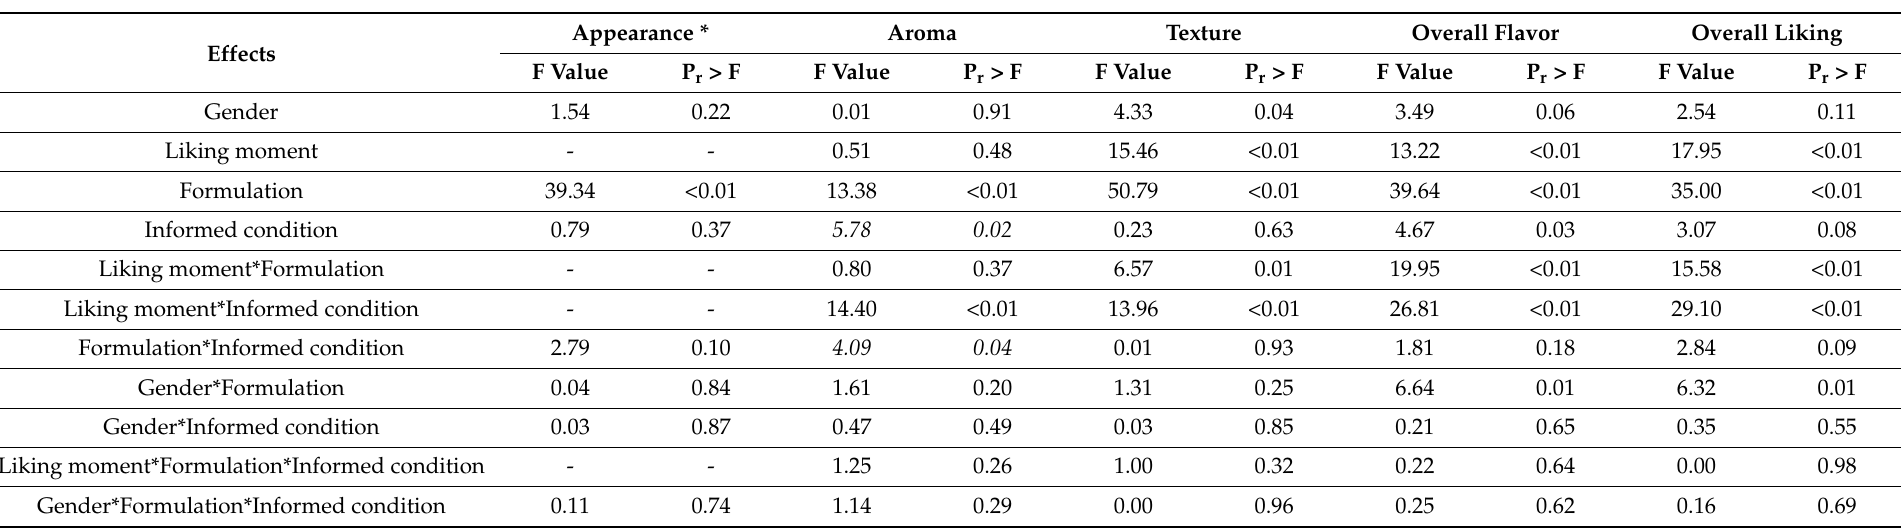
Table 1. ANOVA † table for sensory acceptability ‡ of treatments § .